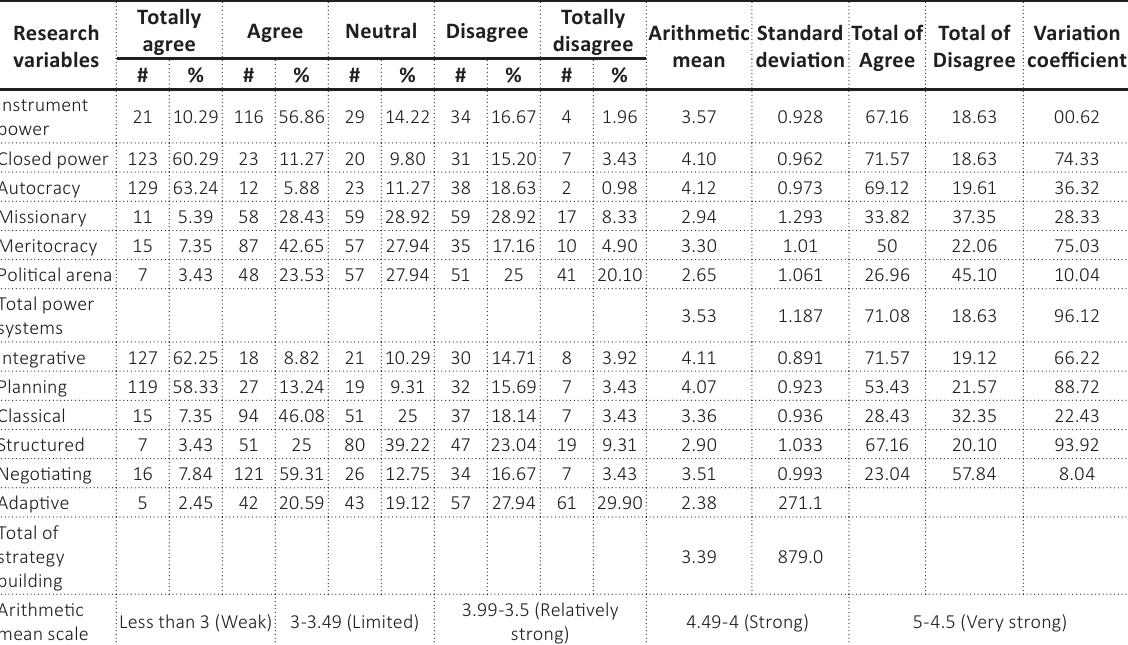
Table 6. Level of research variables in terms of the